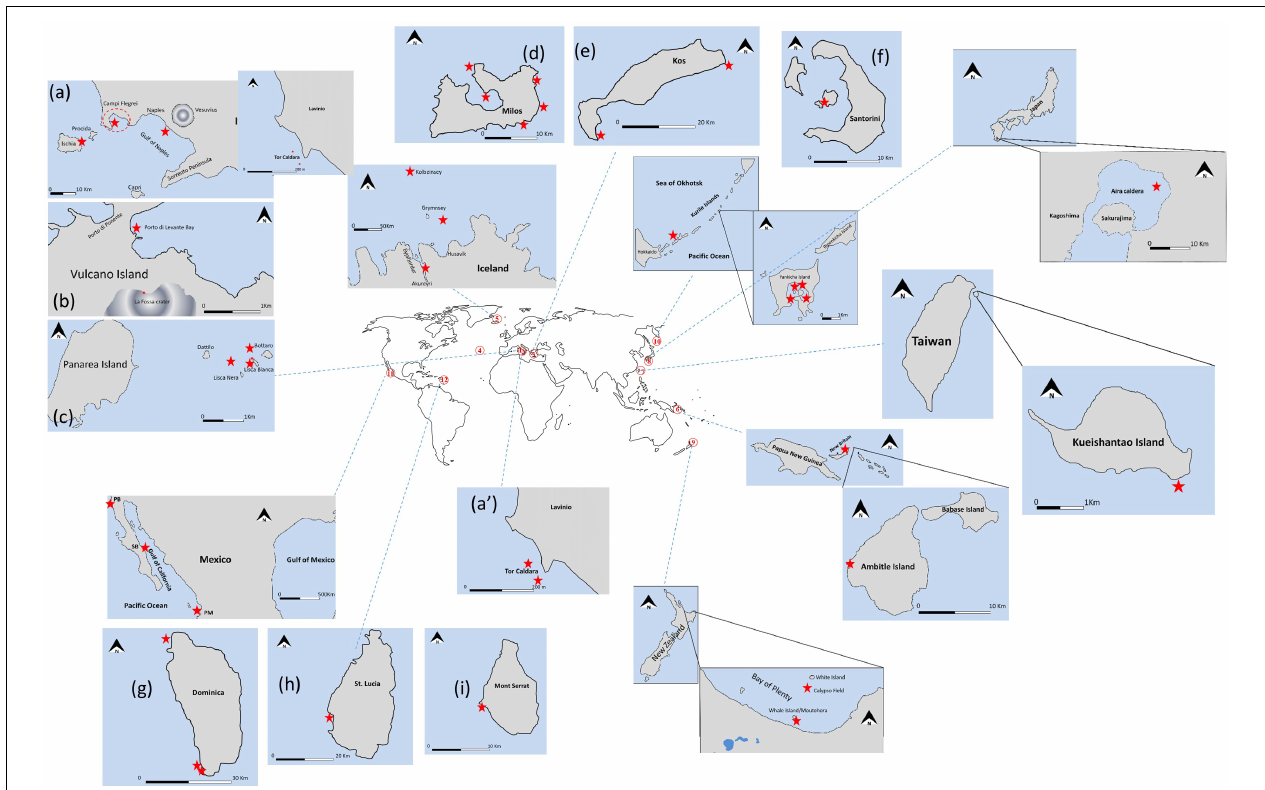
FIGURE 1 | General location of the presented areas 1: Gulf of Naples (a) , Tor Caldara (a’) , 2: Aeolian Islands: Vulcano (b) , Panarea (c) , 3: Aegean Sea [Milos (d) , Kos (e) , Santorini (f) ], 4: Azores Islands, 5: Iceland, 6: Papua New Guinea, 7: Taiwan, 8: Kagoshima Bay, 9: New Zealand, 10: Kurile Islands, 11: Baja California, 12: Lesser Antilles [Dominica (g) , St. Lucia (h) , Mont Serrat (i)